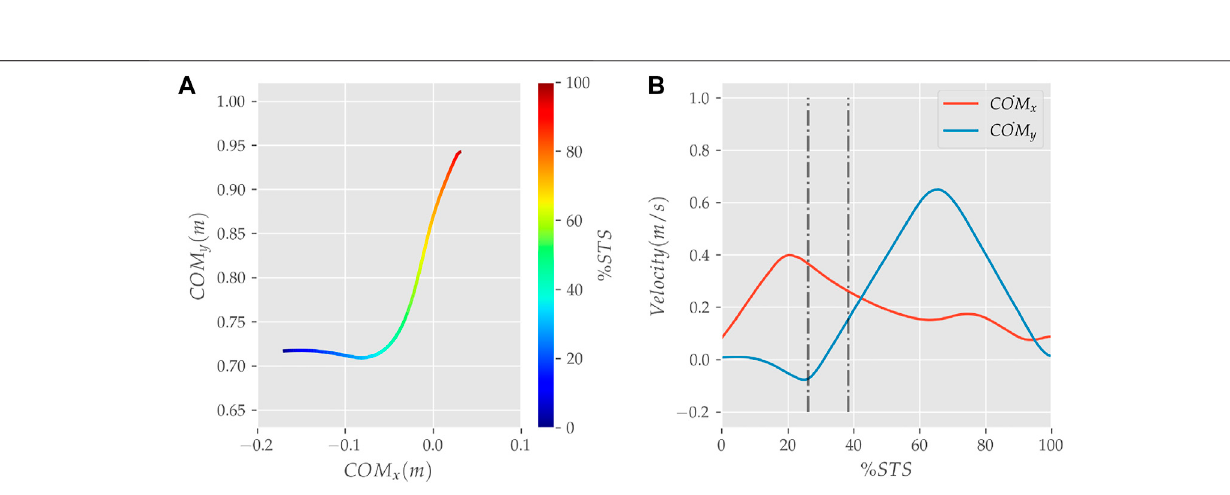
Frontiers in Bioengineering and Biotechnology |